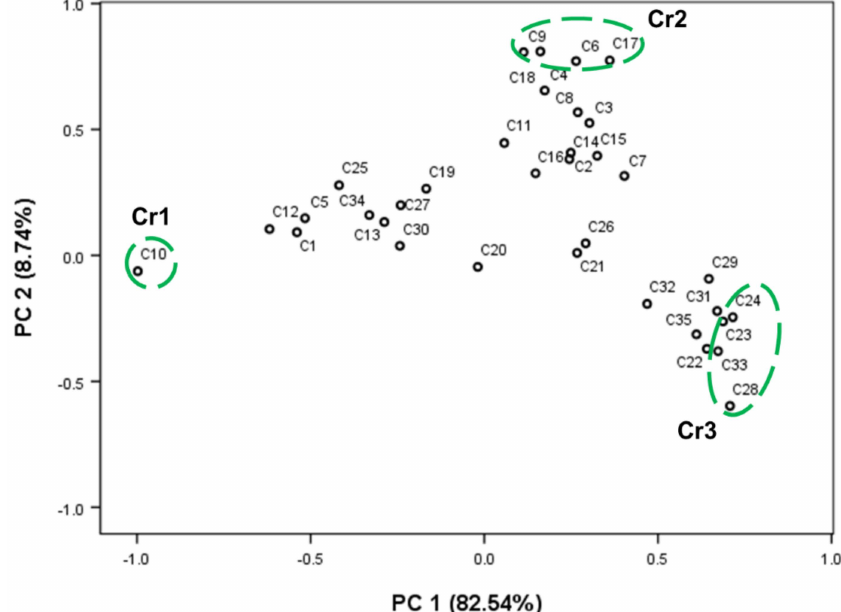
Figure 4. The loading plot of PCA shows the correlations between 35 common chemicals and principal components. Chemicals in green circle: Cr1 had a high correlation with PC1 (negative: artemisia ketone (C10); Cr2 had a high correlation with PC2 (positive: α -terpinene (C6); eucalyptol (C9); terpinen-4-ol (C17); α -terpineol (C18); Cr3 had a high correlation with PC1 (positive: β -cubebene (C23); β -caryophyllene (C24); β -selinene (C28); α -muurolol